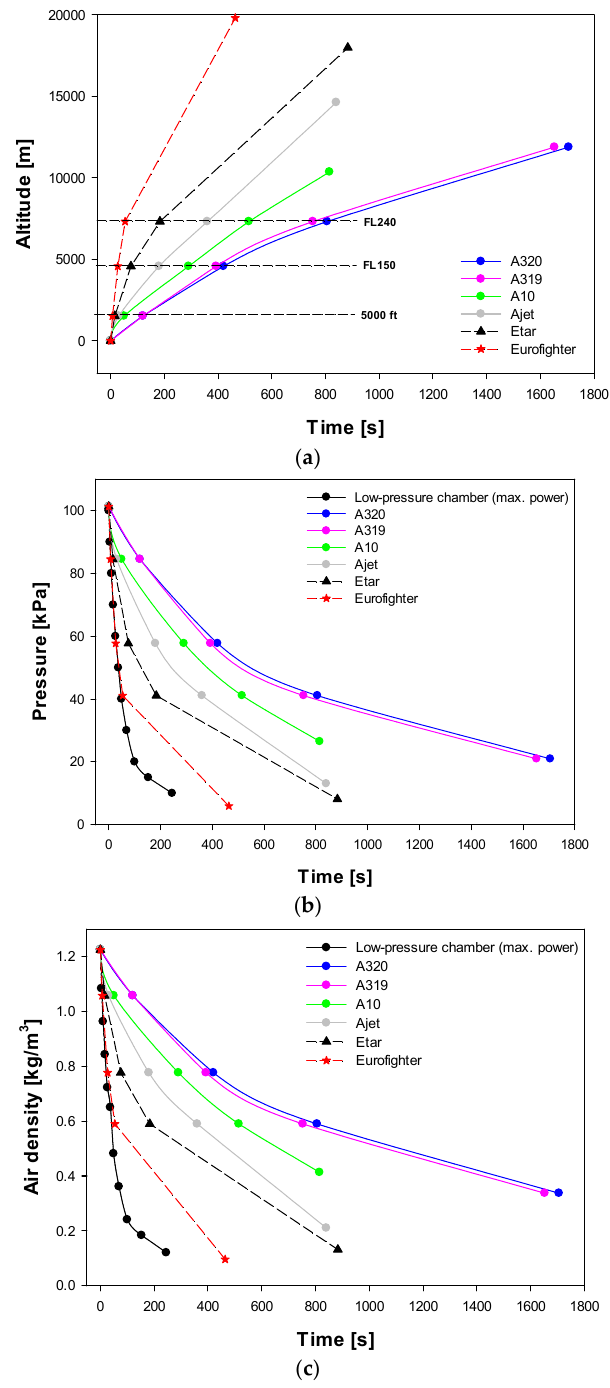
Figure 1. Parameters for different aircraft during the climb stage. ( a ) Altitude versus time [22]. ( b ) Pressure versus time t. ( c ) Air density versus time.